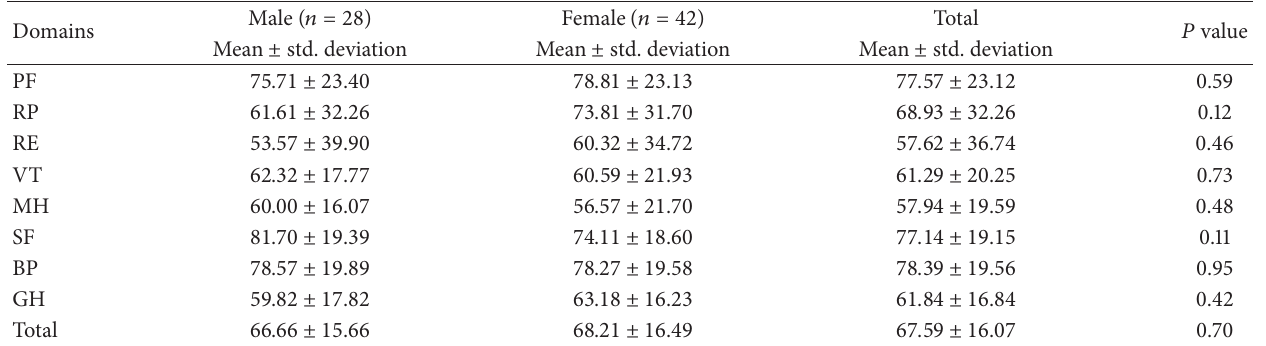
Table 1: Comparison of mean score of QOL (SF-36) in different domains with respect to gender using 𝑡 -test. Male (𝑛 = Domains